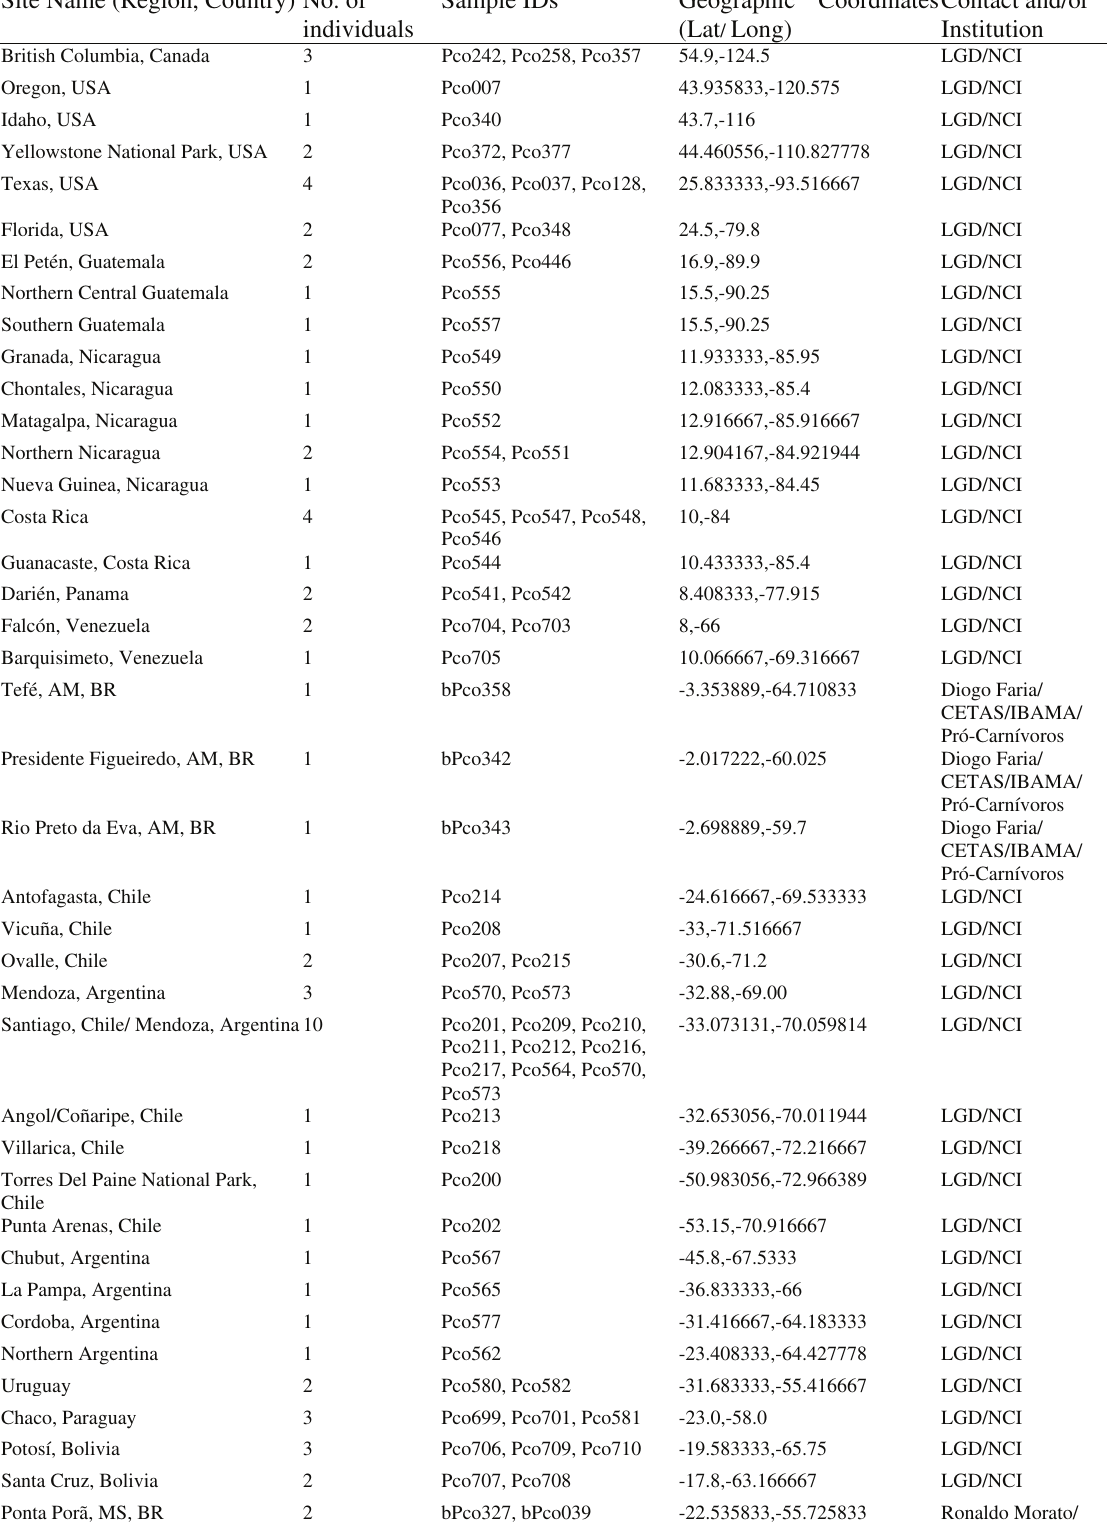
Table S1 - Geographic locales included in this study, including the individuals sampled at each site, and the source of the biological material analyzed